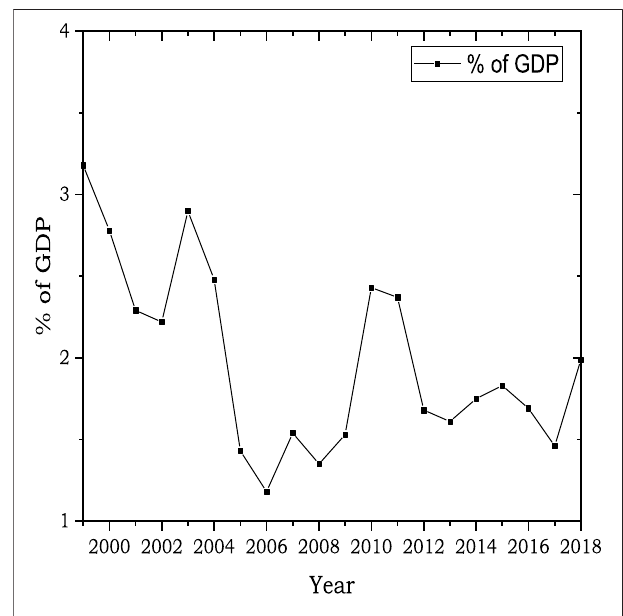
FIGURE 5 | Gross domestic product (GDP) from 2000 to